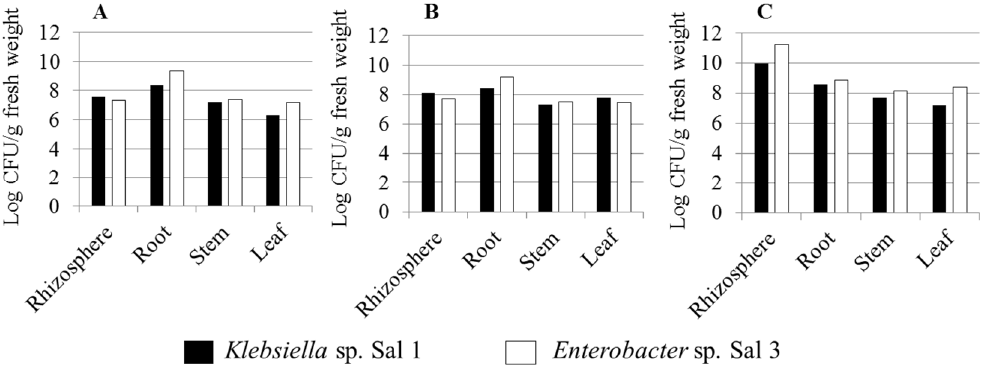
Figure 8. Colonization of the inoculants in tomato plant parts in nitrogen limiting ( A ) and non-limiting ( B ) conditions in test tubes and nitrogen non-limiting conditions in petri dishes ( C ).